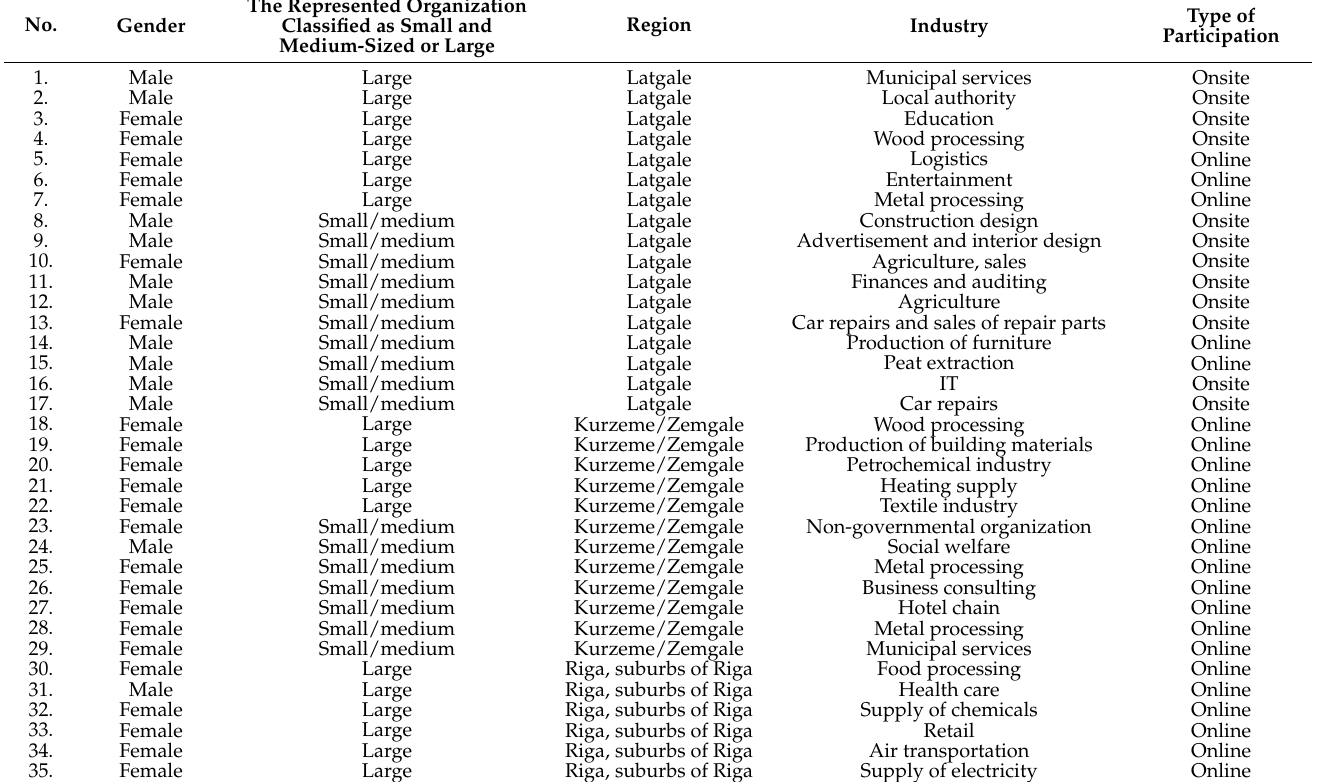
Table A3. Characteristics of the focus group participants—employers and type of their